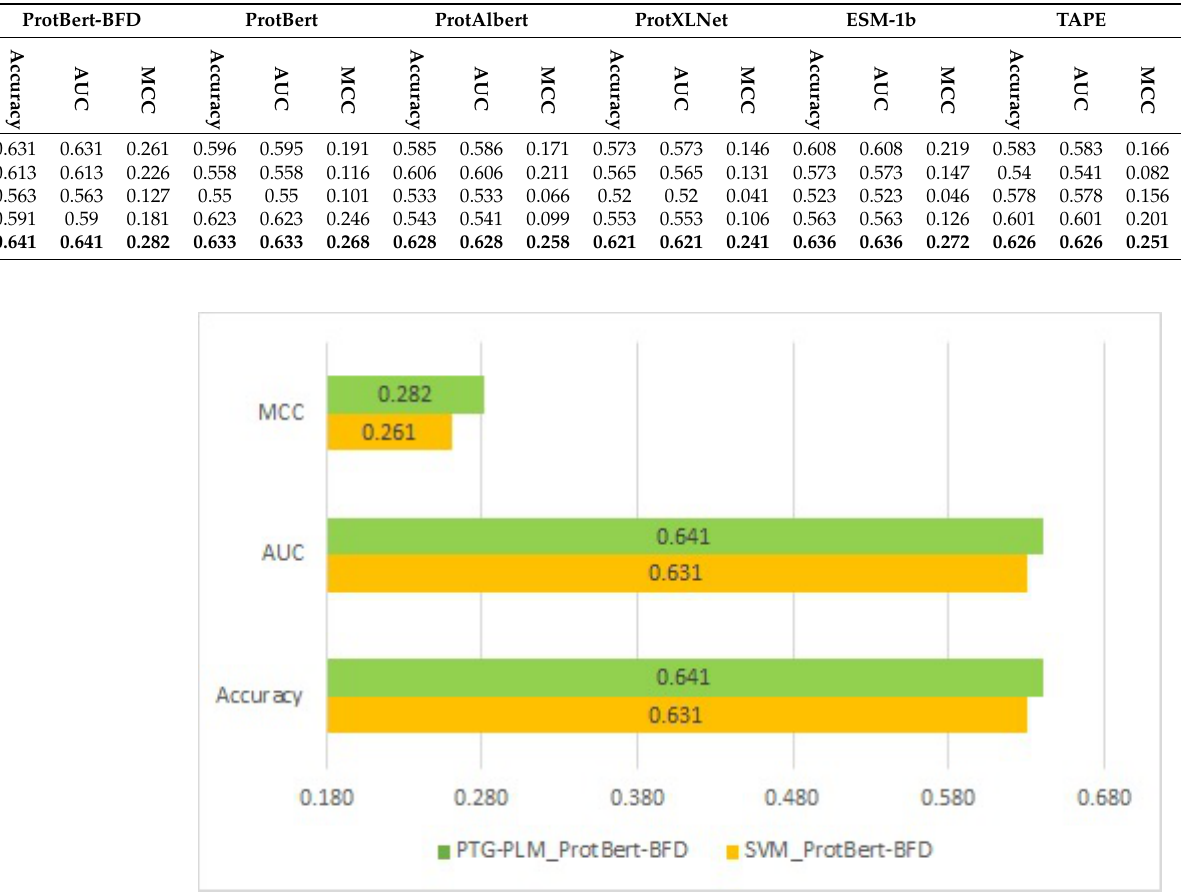
Figure 6. Comparison of performance between the best PTG-PLM model (based on ProtBert-BFD) and the best-supervised learning model (SVM based on ProtBert-BFD) on the Kgly independent